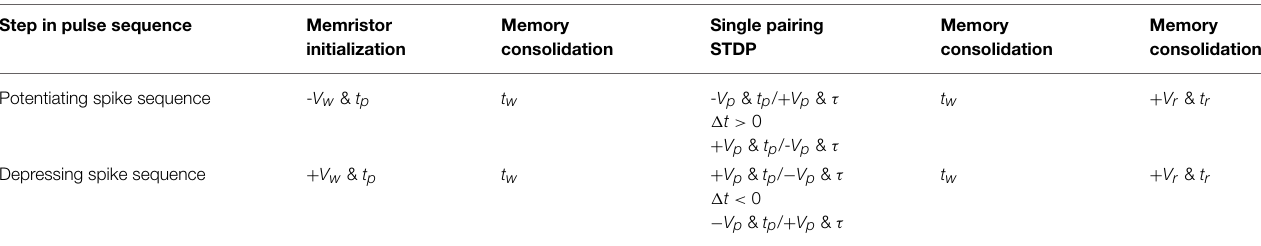
TABLE 1 | Parameters for the potentiating spike sequence ( 1 t > 0) and for the depressing spike sequence ( 1 t < 0) during Memristor initialization, Memory consolidation, and Single pairing